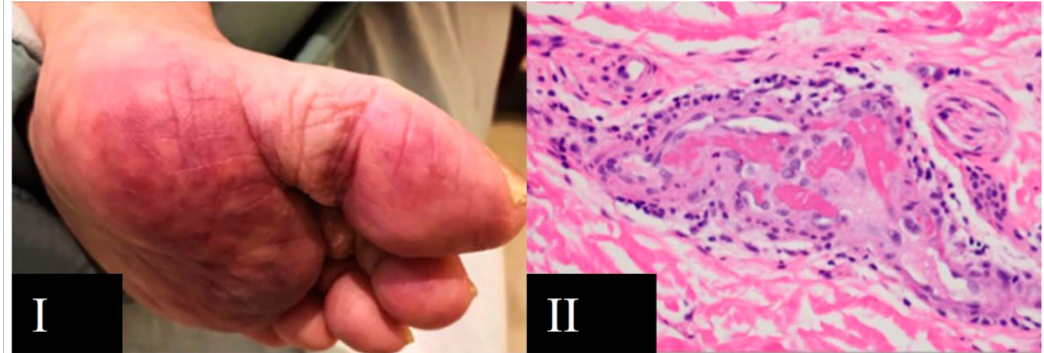
Figure 5. Livedo reticularis associated with COVID-19. ( I ) Livedo reticularis in the plantar region; ( II ) skin biopsy showing pauci-inflammatory thrombogenic vasculopathy (HE × 400). Arias Arguello A. (2020)